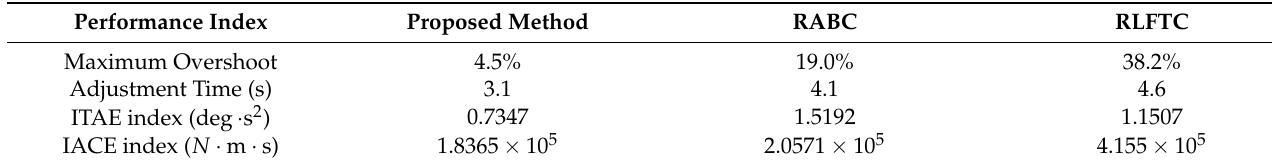
Table 2. Performance indexes of the β -channel.